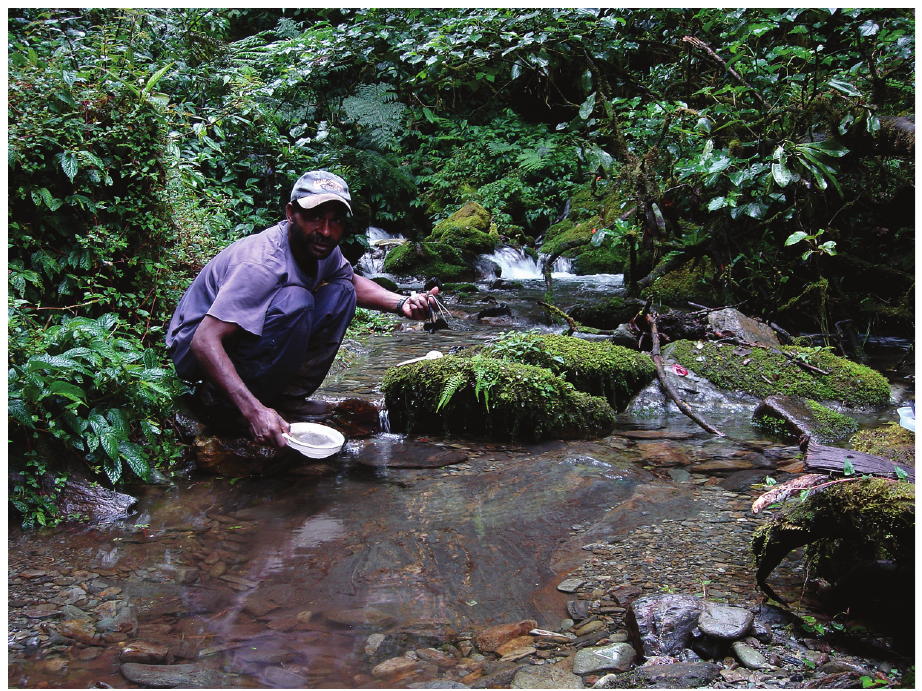
Figure 41. Papua New Guinea, Marawaka area, mid-montane forest stream, with Andrew Kinibel; photo by M.